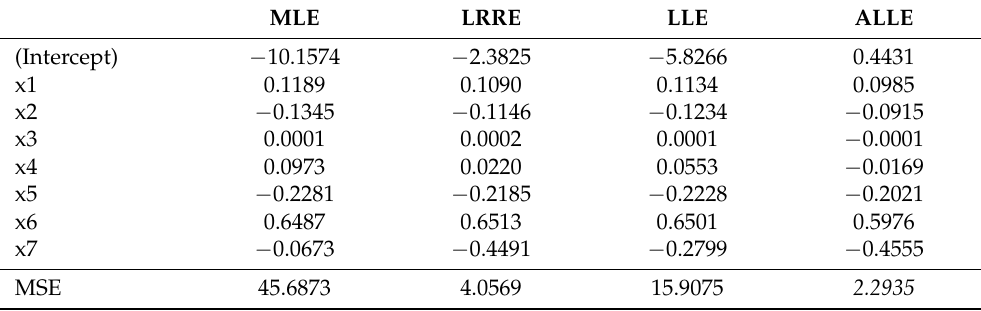
Table 5. Regression estimates and MSEs of the logistics regression estimators for the prostate cancer data.